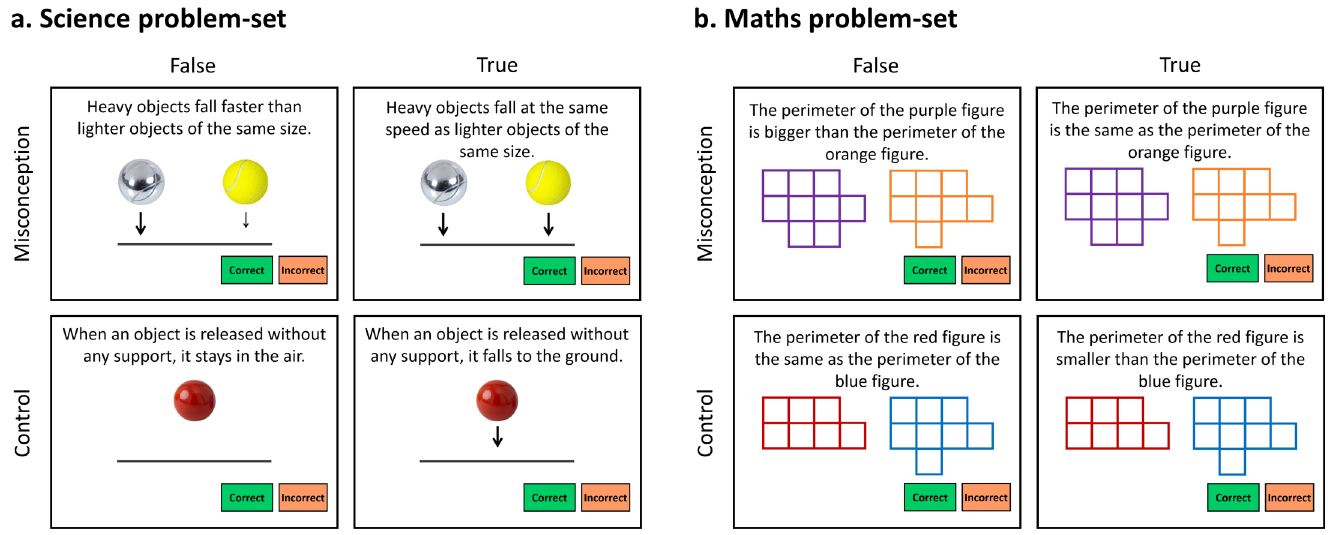
Fig 1. Example problem-sets for (a) science and (b) maths. Text and image size has been increased to enhance legibility. Correct and incorrect ‘buttons’ remained on the screen to remind participants which key to press.